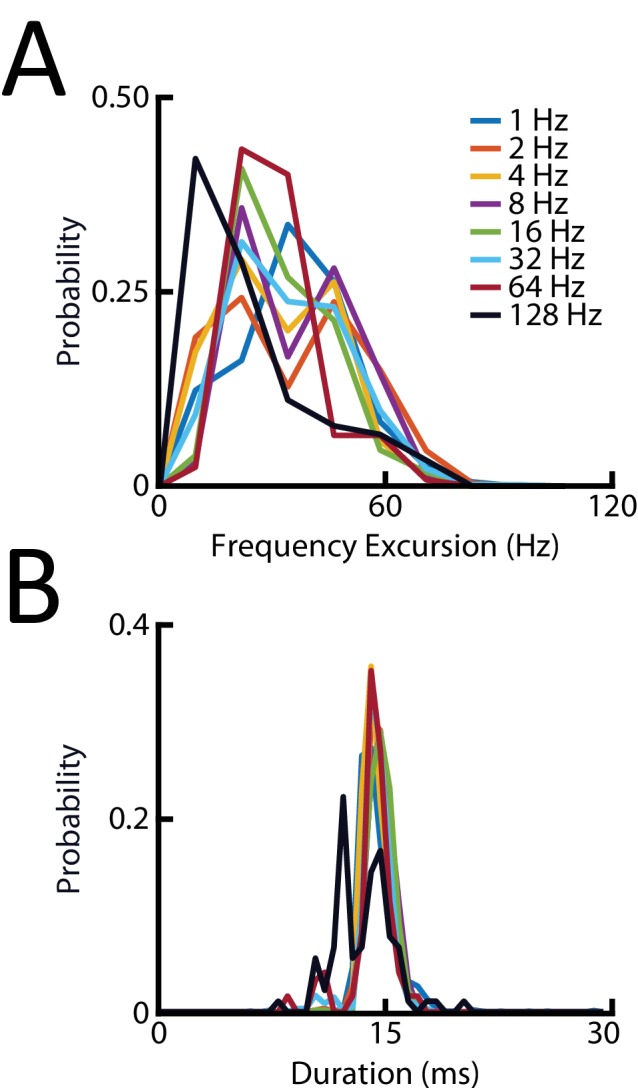
Characteristics of real chirps do not vary across baseline beat frequencies.(A) Probability distributions of the frequency increase of small chirps recorded at different baseline beat frequencies. All samples originate from the same distribution (Kruskal-Wallis test, df = 7; Chi2 = 0.38; p=0.9998) (B) Probability distributions of the duration of small chirps recorded at different baseline beat frequencies. Note that all samples originate from the same distribution (Kruskal-Wallis test, df = 7; Chi2 = 9.74; p=0.2038).DOI:
http://dx.doi.org/10.7554/eLife.24482.012
10.7554/eLife.24482.013Figure 3—figure supplement 1—source data 1.Source data for Figure 3—figure supplement 1.